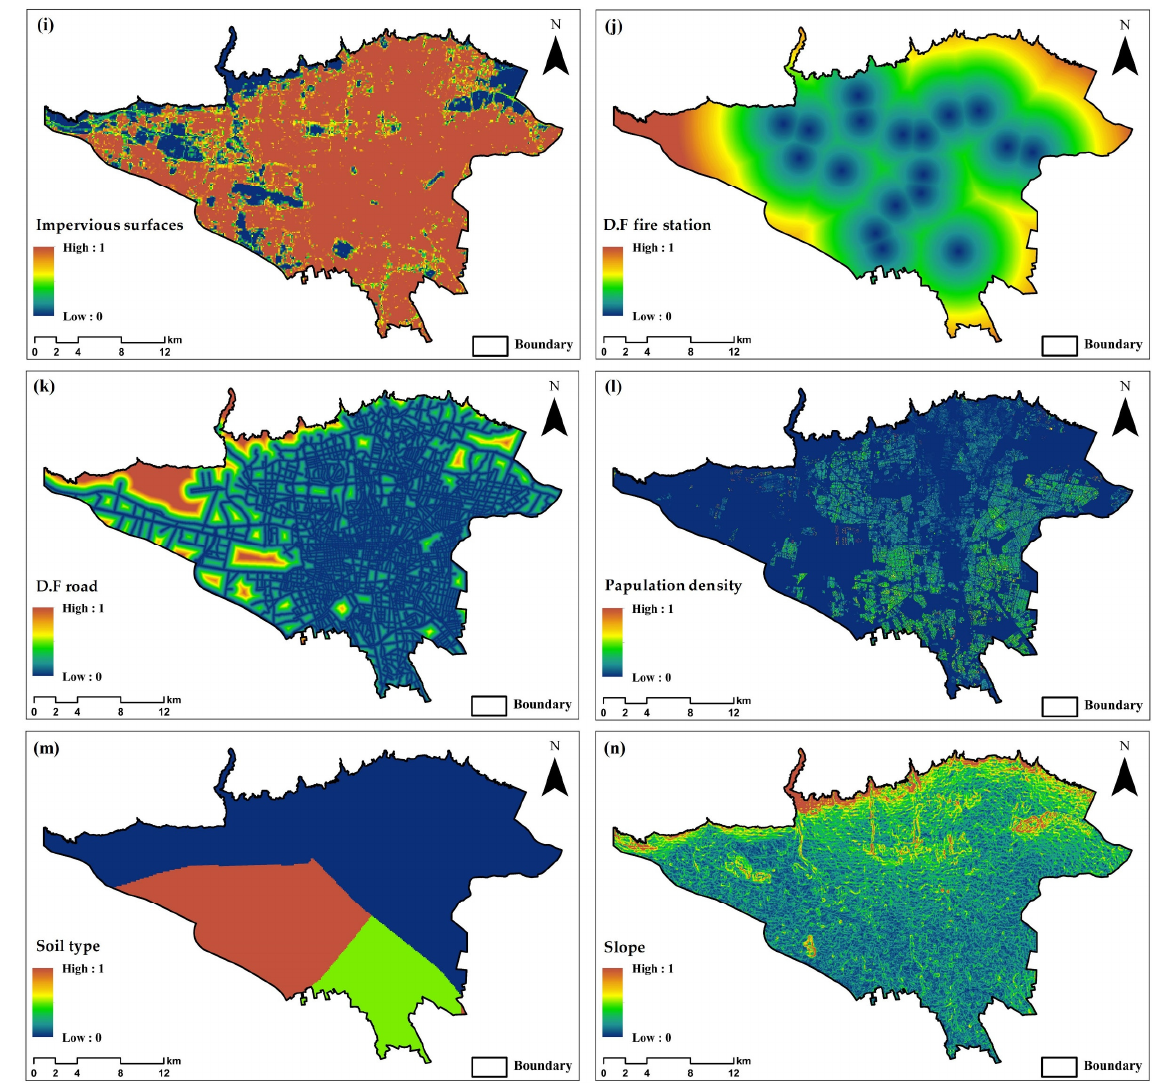
Figure 5. The criteria map ( a ) elevation; ( b ) aspect; ( c ) distance from health centres; ( d ) flow accumulation; ( e ) vegetation density; ( f ) land use; ( g ) distance from river; ( h ) rainfall; ( i ) impervious surfaces; ( j ) distance from fire station; ( k ) distance from road; ( l ) papulation density; ( m ) soil type; ( n ) slope.